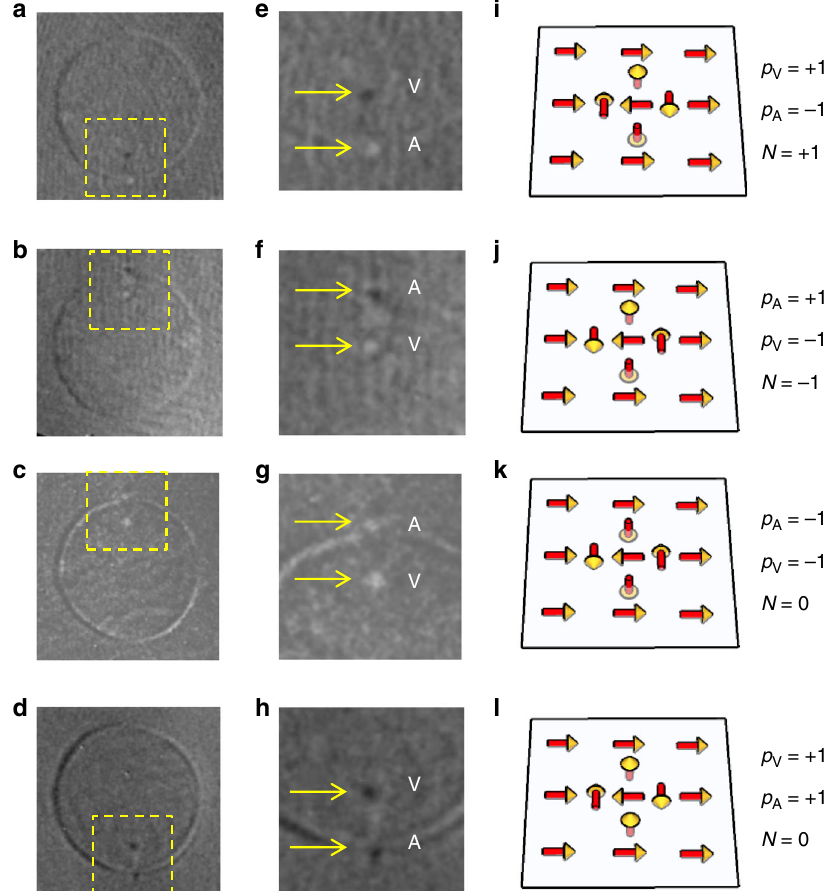
Fig. 3 Direct observation of the out-of-plane cores of the meron pairs. a – d Typical out-of-plane magnetic contrast images at 35 Oe. e – h Corresponding zoomed in images around the cores of the meron pairs. “ V ” and “ A ” denote the vortex core and antivortex core, respectively. i – l Corresponding schematic views of the magnetization pro fi les of the meron pairs. All four combinations of the core polarities are observed. The two cores are always bonded together and locate near either the top or bottom edge of the disk (the choice depends on the in-plane circulation direction of the